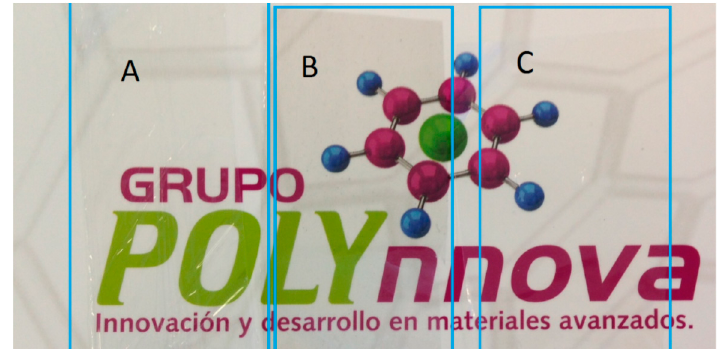
Figure 3. Photograph of ABA films: ( A ) reference film, 0 wt % MWCNT, ( B ) film with 1 wt % MWCNT (fabricated with masterbatch: iPP MFI=2.5 , F-U), and ( C ) film with 0.01 wt % MWCNT (fabricated with masterbatch: iPP MFI=2.5 , V-U).